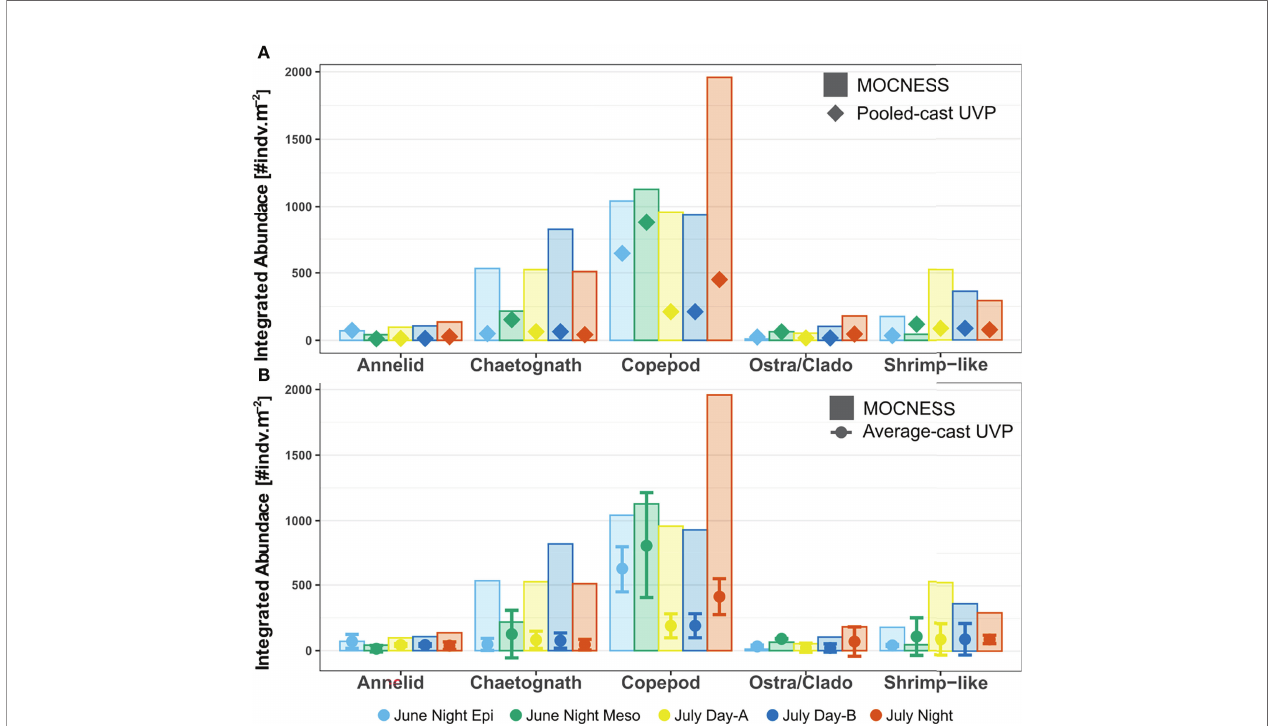
FIGURE 6 | Depth integrated abundance for each speci fi c taxon comparing MOCNESS estimates to (A) pooled-cast UVP and (B) average-cast UVP calculations. For average-cast calculations, error bars indicate standard deviation between depth integrated abundance of similar UVP pro fi les. Colors indicate the corresponding integrated pro fi le/tow. Note that the June night tow was integrated as an epipelagic region (0-250) and a mesopelagic region (250-1000). There were no signi fi cant differences in integrated abundance for taxon-speci fi c comparisons between the MOCNESS vs pooled-cast UVP; MOCNESS vs average-cast UVP; nor the pooled- cast vs average-cast calculation (Paired Wilcox sign rank test, p >